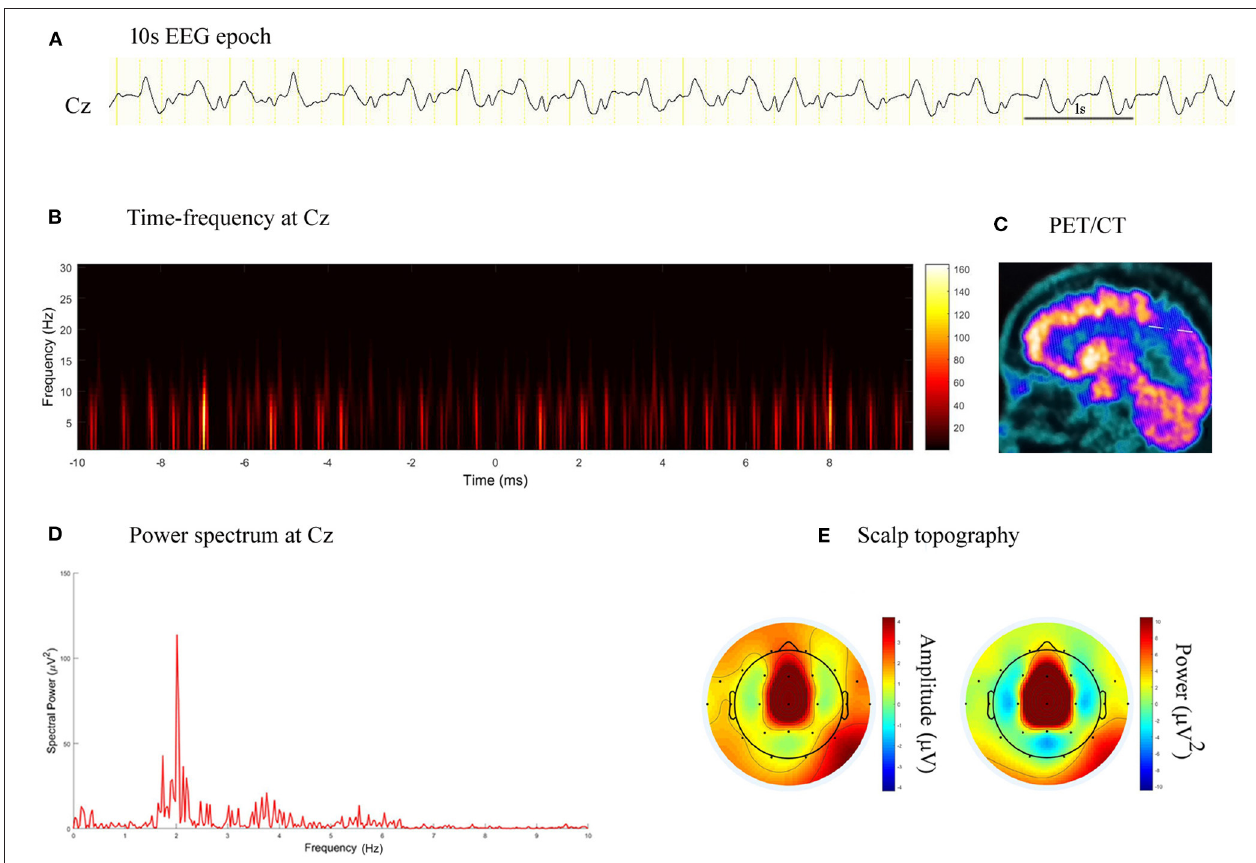
FIGURE 5 | EEG epoch, time-frequency and power spectrum analysis, and PET/CT scan in a patient with stroke. (A) A 10s EEG epoch at Cz electrode. (B) Time-frequency analysis showed PDs had a frequency of 2.0Hz. (C) PET/CT scan demonstrated decreased FDG uptake in the right paracentral lobule. (D) Spectral power value for PDs of 20s at 2.0Hz was 113.90 µ V 2 . (E) Scalp topography showed the PDs pattern located in the midline central.